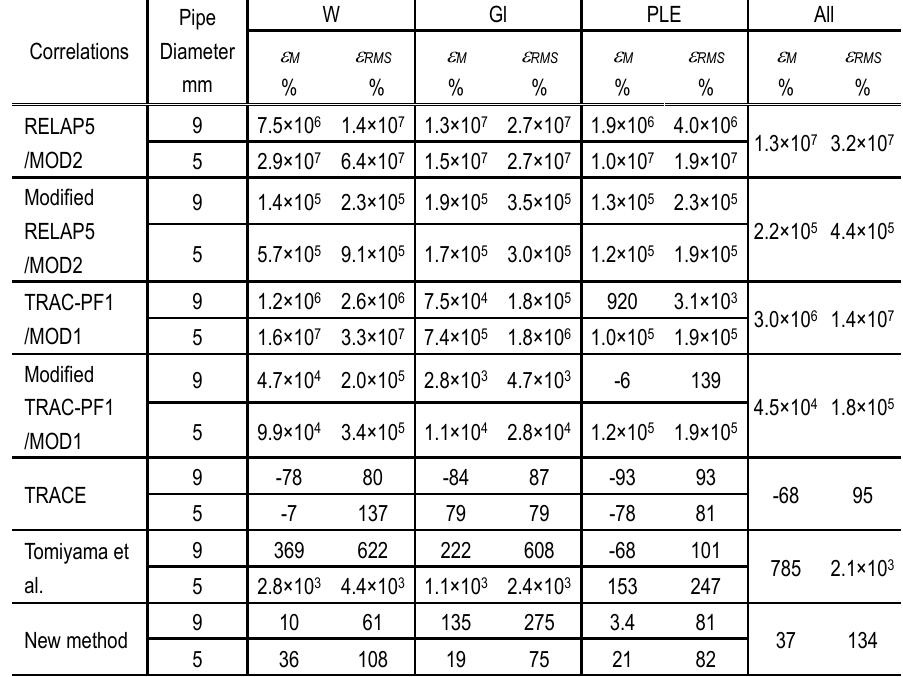
(g) New correlation Fig. 5 Comparisons of interfacial friction force in slug flow between experiment and calculation Mean and RMS errors in interfacial friction force prediction by 7 correlations in slug